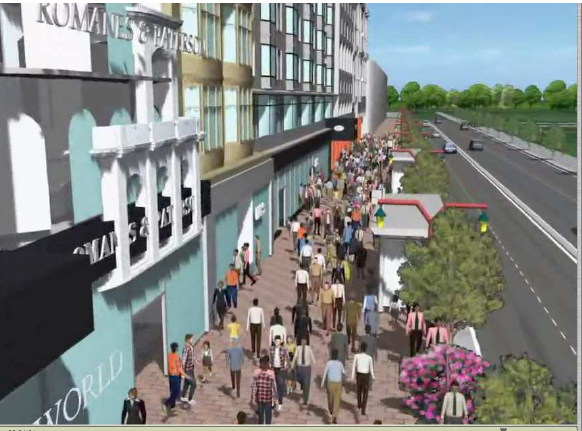
Figure 14. Sample of pedestrian simulation